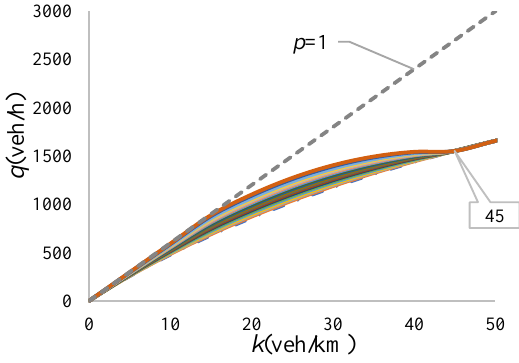
Figure 8. q-k variation with different values of p . Figure 8. q - k variation with different values of p